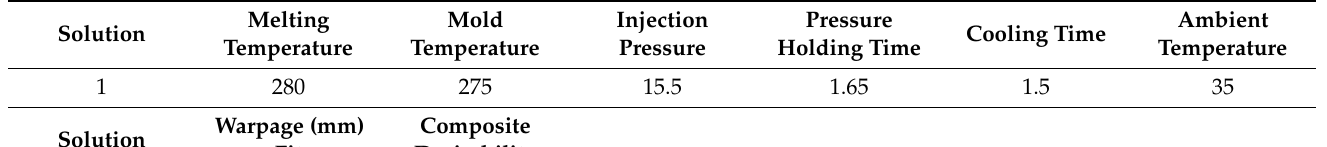
Table 8. Optimized solution for warpage.